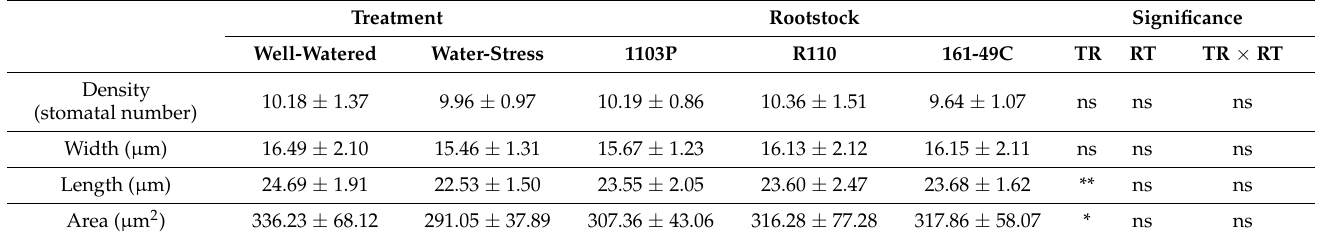
Values are means ± standard error of six vines per treatment. Significant differences for treatment (TR), rootstock (RT), and TR × RT were analyzed by two-way ANOVA (ns, not significant; *, p ≤ 0.05; **, p ≤